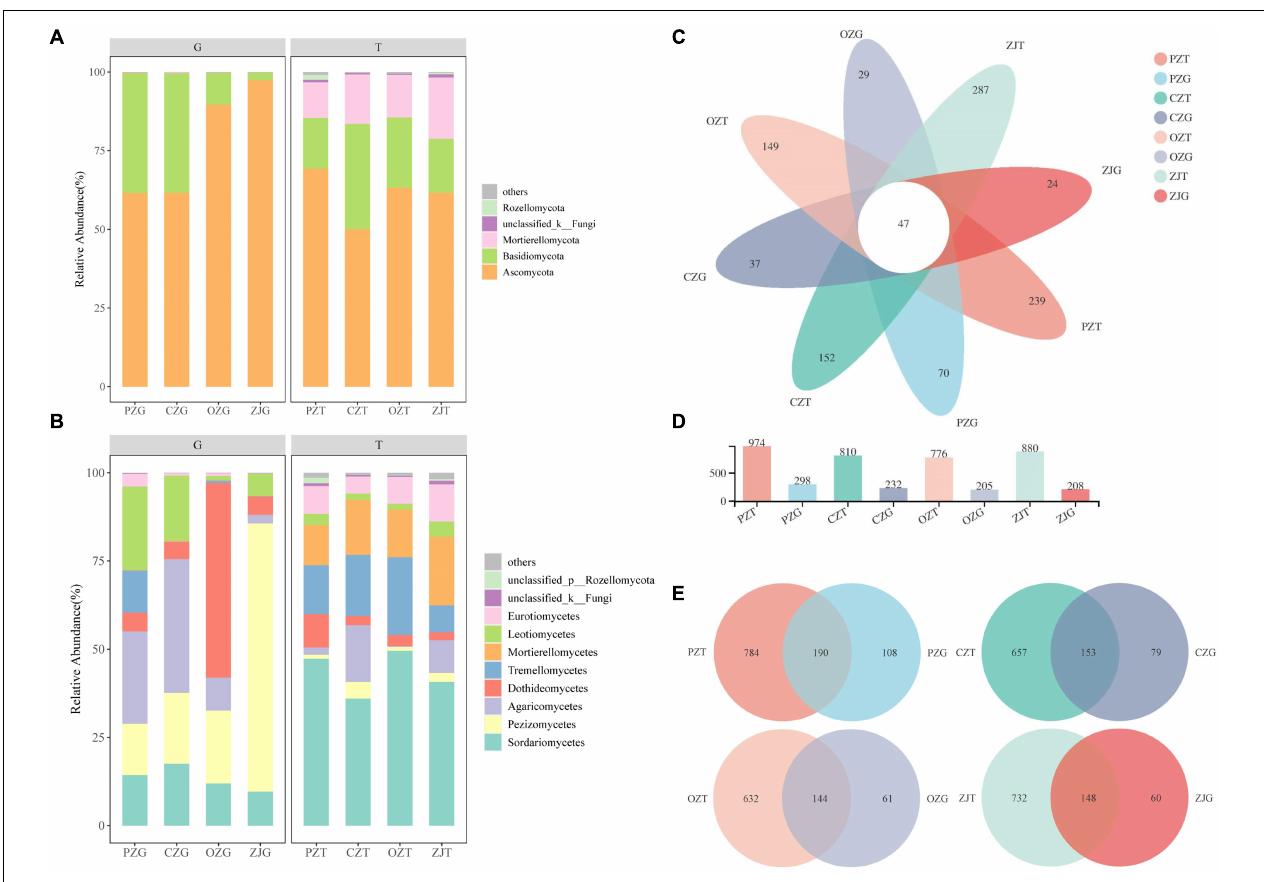
FIGURE 1 | Fungal composition of the rhizosphere soil (T) and root endospheres (G) of hazelnut species: relative abundances of soil fungal community structure at the phyla (A) and class (B) levels; Venn diagram of core OTUs among each of hazelnut species (C–E) .